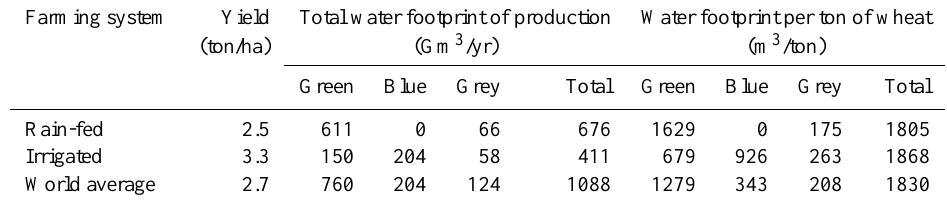
Table 3. The global water footprint of wheat production in rain-fed and irrigated lands (1996–2005). Farming